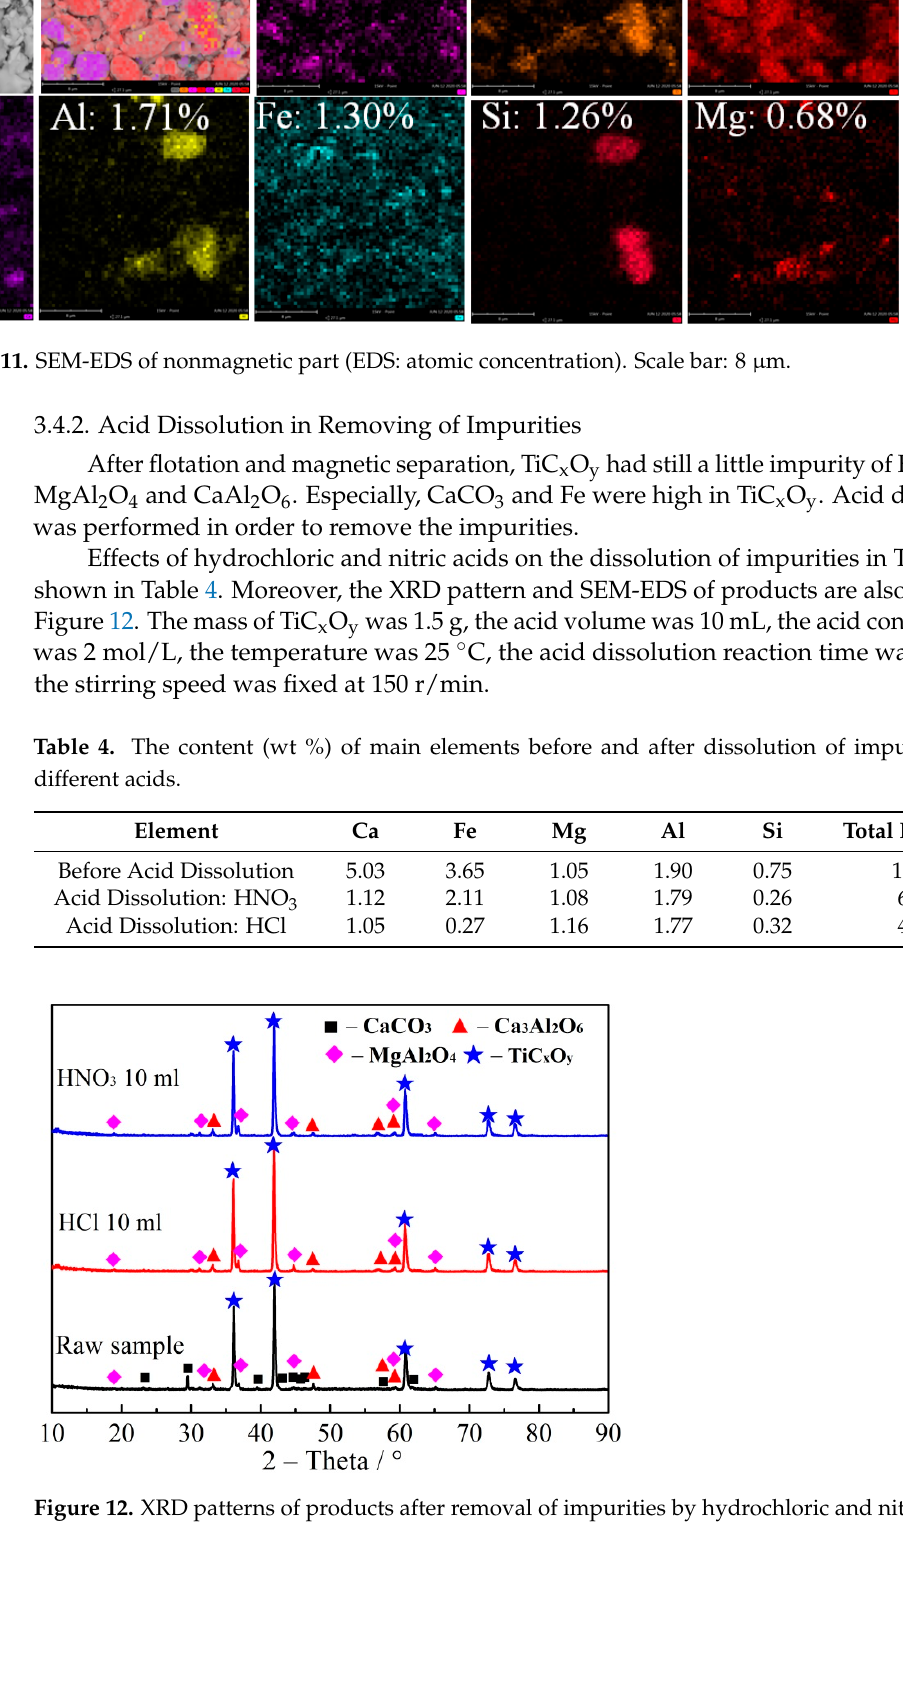
Figure 10. ( a ) XRD of magnetic separation product (particle size: − 50 μ m + 38 μ m); ( b ) XRD pat- terns of the flotation product and the magnetic and the nonmagnetic parts (particle size: − 38 μ m).